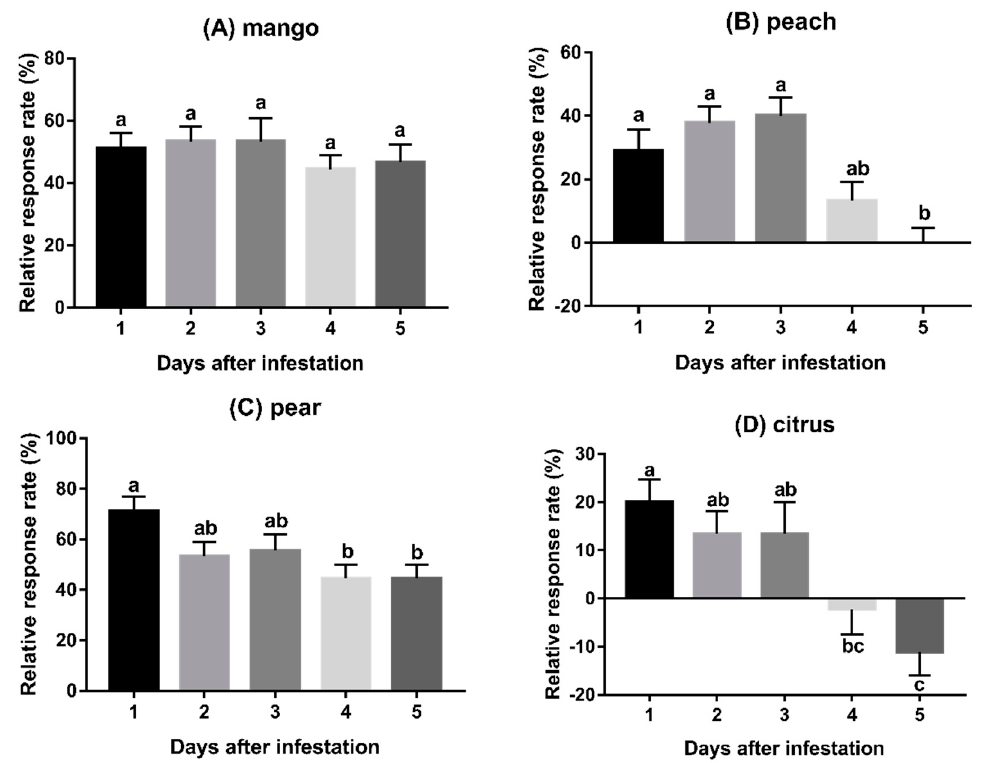
Figure 2. Behavioural responses of F. arisanus females to fruits infested for different numbers of days. ( A ) mango, ( B ) peach, ( C ) pear, ( D ) citrus. The data are expressed as mean ± SD. Different lowercase letters above bars denote significant differences by Tukey’s multiple range test ( p < 0.05). N = 9.